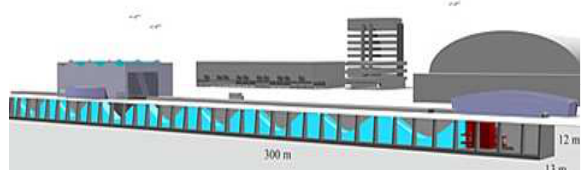
Figure 1: Design of the new Delta Flume facility to be opened in Nov.